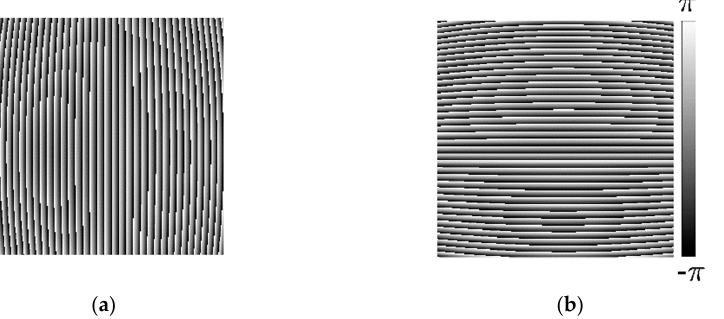
Figure 3. Simulated distorted fringe-patterns of size 512 × 512 pixels by a single parameter division model with a distortion parameter λ = − 1 × 10 − 6 and distortion center ( 273,289 ) . The longitudinal fringe-patterns with a phase shift of 0, π /2, π , 3 π /2 are at the first row and the transverse fringe-patterns with a phase shift of 0, π /2, π , 3 π /2 are at the second row.